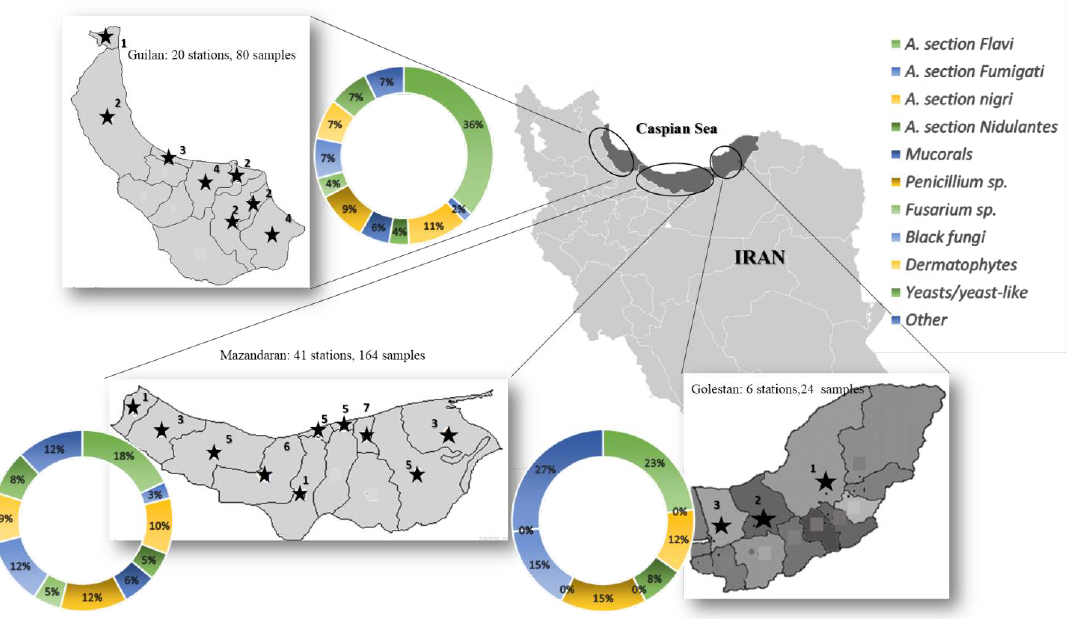
Figure 1. Distribution of the stations and isolated species in the Caspian coastline stations regarding geographical borders (Mazandarn, Guilan, and Golestan provinces). Each ( (cid:70) ) indicates cities and the numbers represents the number of stations for sampling in each city. Table 3. Antifungal susceptibility profile of Aspergillus species isolated from mycosands. Table 2. Detailed data for identified isolates according to the sample